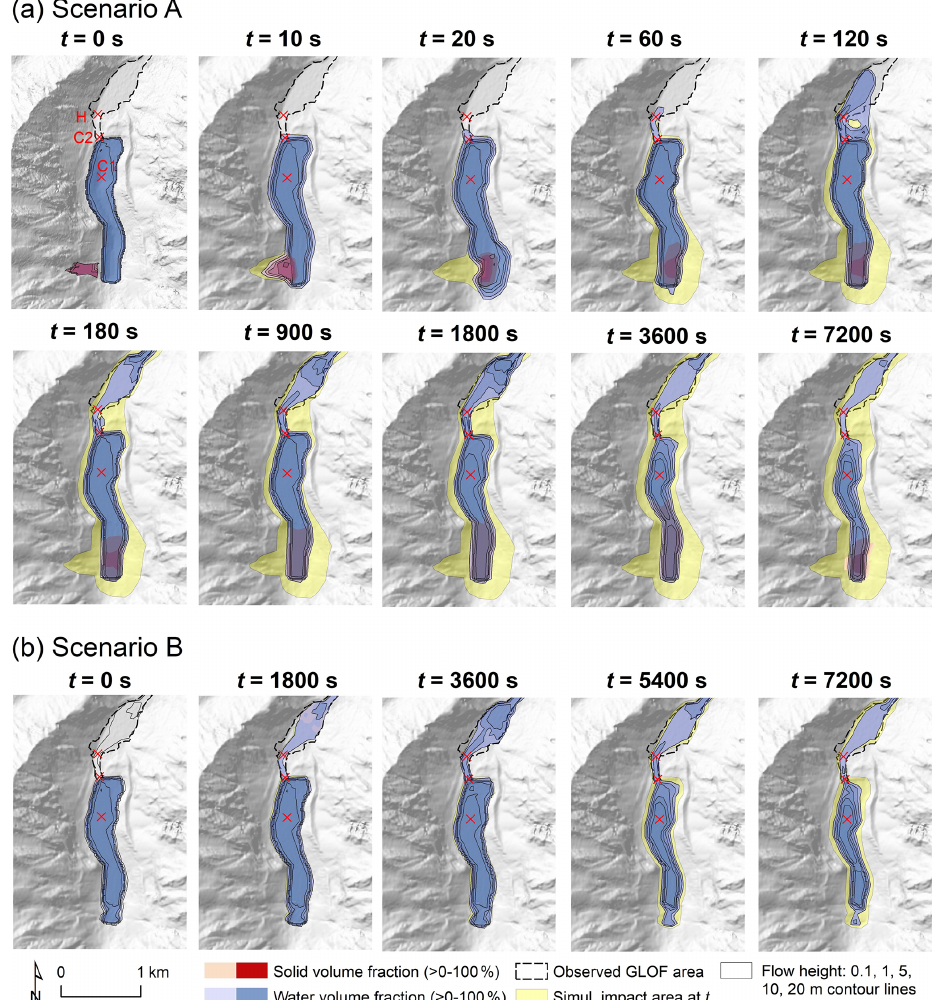
Figure 10. Evolution of flow height and GLOF impact area as well as solid and water volume fractions during the first 2h of the event, as simulated with r.avaflow for (a) Scenario A and (b) Scenario B. Only the section until the floodplain immediately downstream from the moraine dam is considered in these simulations. The base map is a shaded relief map based on the DEM generated from Ziyuan-3 stereoscopic pairs and the simulation